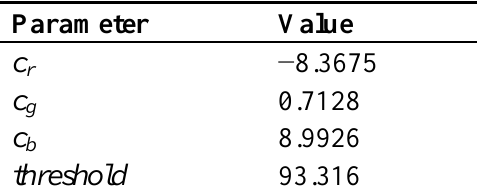
Table 1. Final values of the segmentation parameters for a training set of 20 images selected at